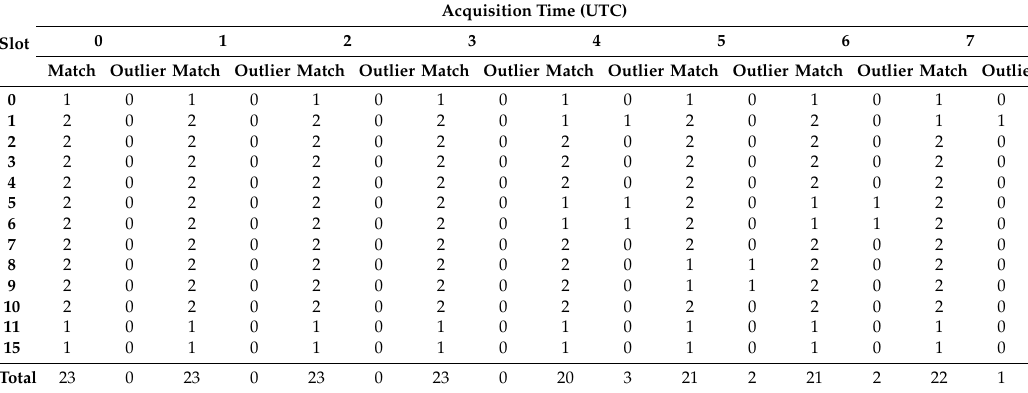
Table 5. Frequency-matching results.